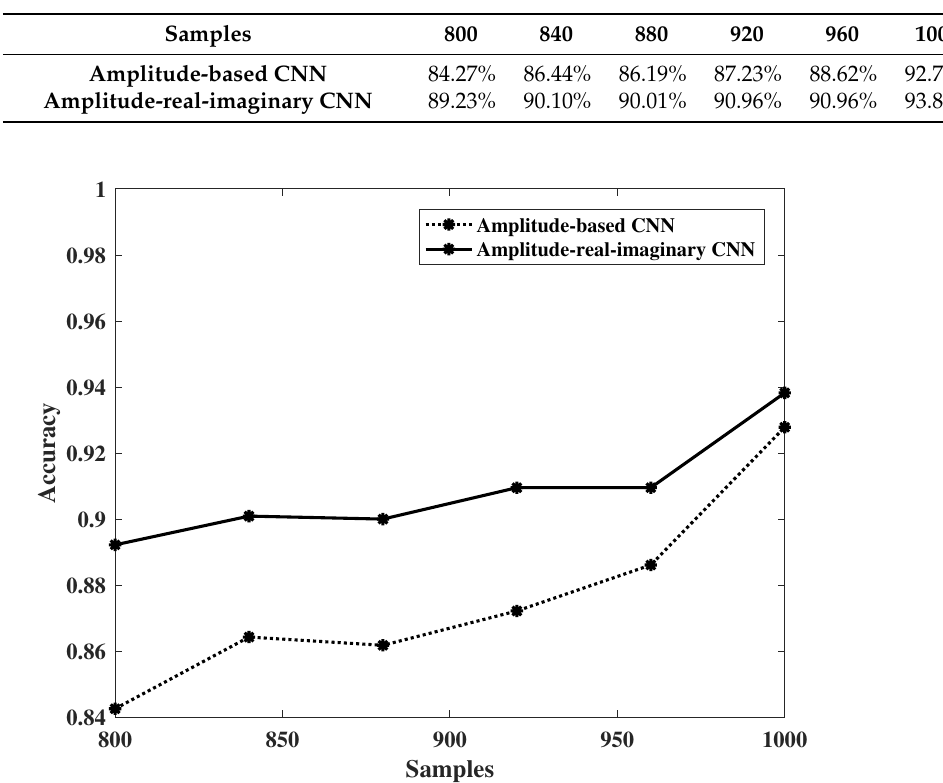
Figure 12. Experimental results based on different networks under